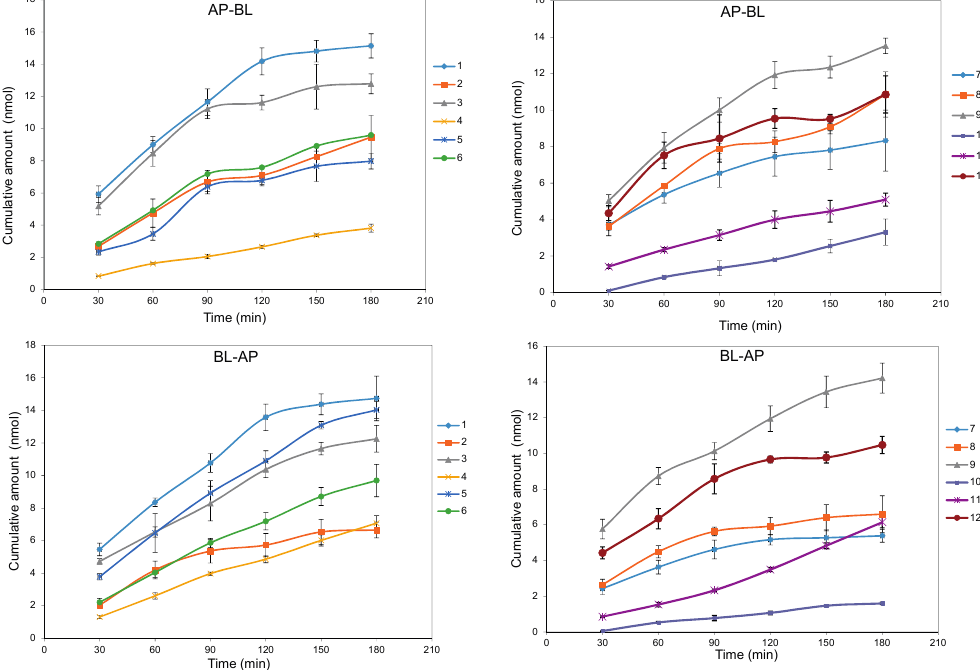
Figure 2. The bidirectional transport cumulative amounts of twelve coumarins in MDCK-pHaMDR cell monolayer as a function of time at 50 μ M. Data are the mean ± S.D. ( n = 6).